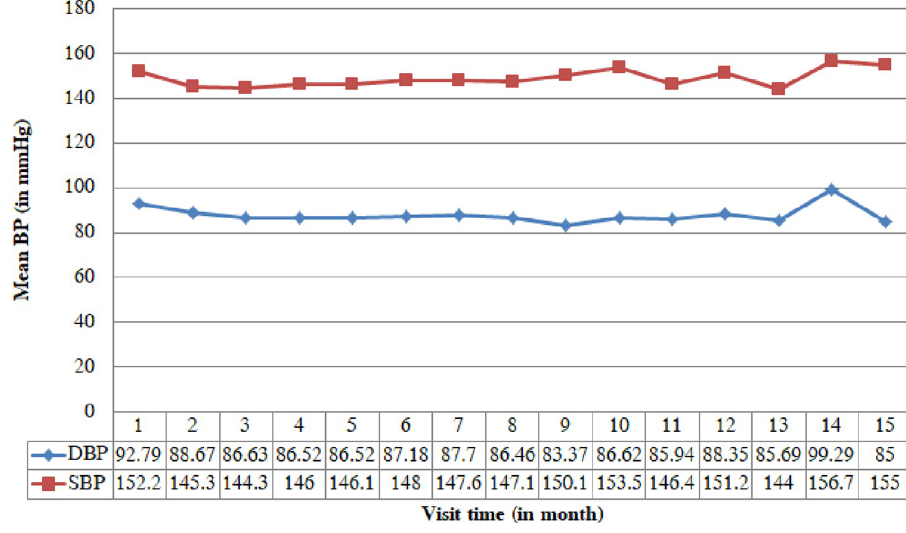
Fig 1. The average BPs plot over time.